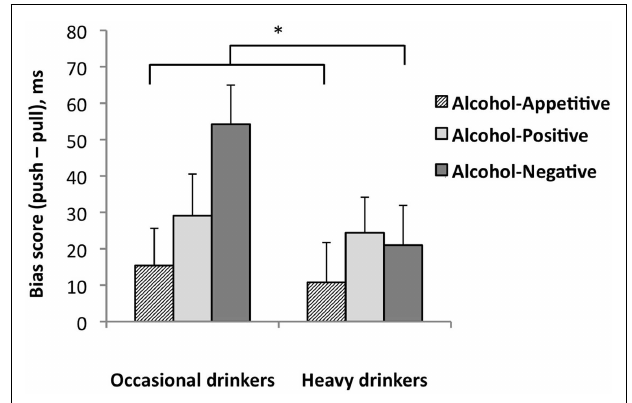
FIGURE 4 | Emotional prime approach avoidance task bias-scores for alcohol in the appetitive, positive, and negative contexts in heavy drinkers ( n = 65) and occasional drinkers ( n = 50) . Mean bias-scores are shown with standard error bars; * p <